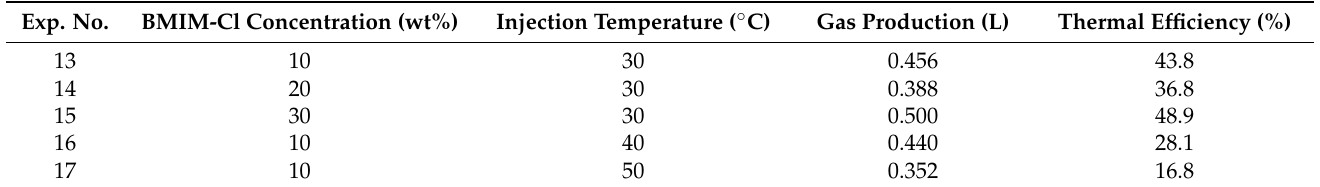
Table 4. The initial experimental conditions and results of CH 4 production by the injection of BMIM-Cl solution.